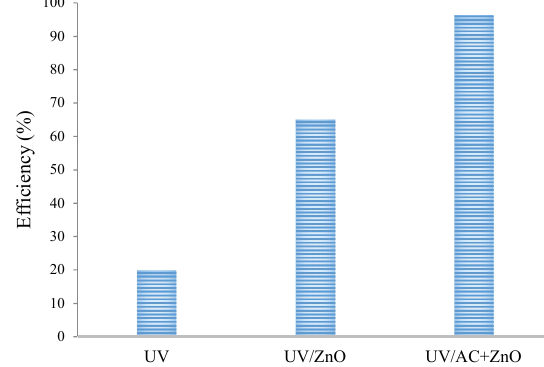
Fig. 10. Comparison of efficiency of various processes for acid blue 113 dye removal in optimum conditions (pH: 3, initial dye concentration: 100 mg/l, modified photocatalyst concentration: 100 mg/l, reaction time: 30